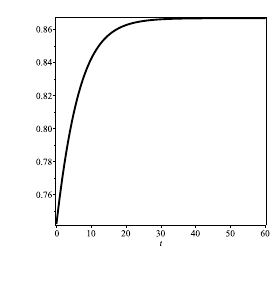
Figure 4. Transitional dynamics for u ( t ) - Naz et